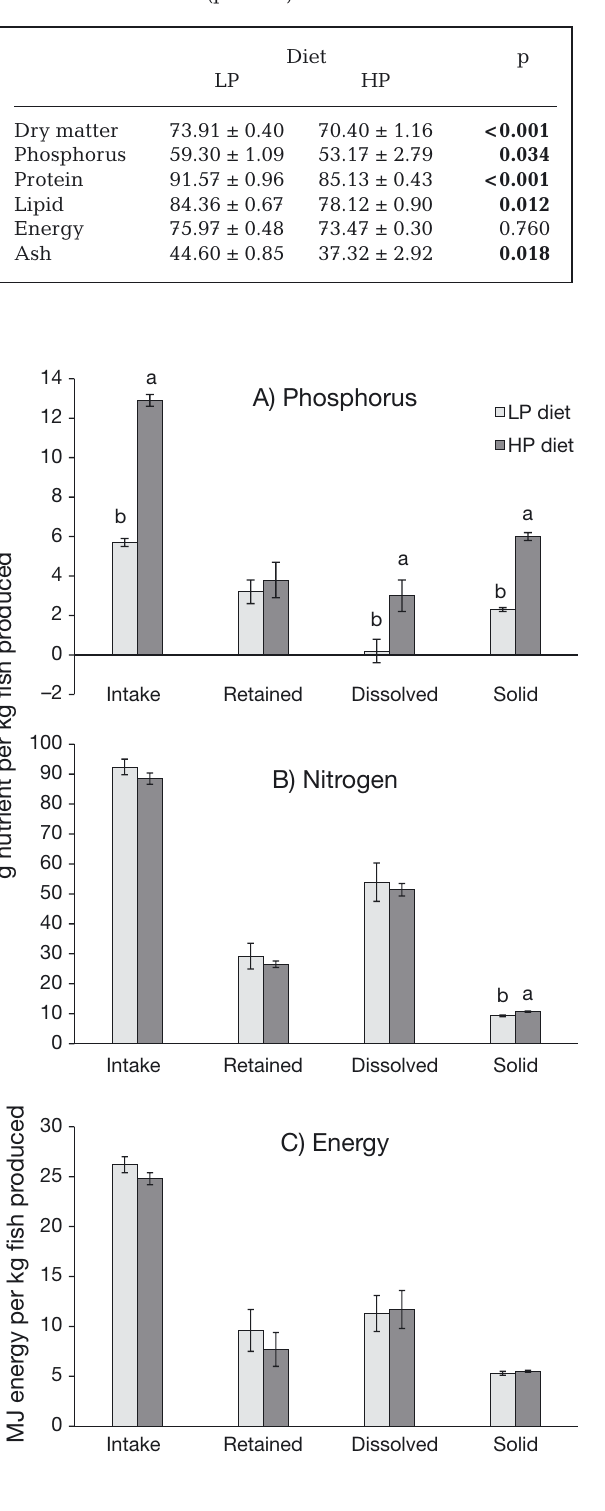
Table 4. Concentration (ppm) of inorganic anions in tank wa- Table 3. Apparent digestibility coefficient (ADC) (see Eq. 8 in ter at each sampling event for rainbow trout Oncorhynchus ‘Materials and methods’) for dry matter, phosphorus, protein, mykiss fed low-phosphorus (LP) and high-phosphorus (HP) lipid, energy and ash of rainbow trout Oncorhynchus mykiss diet. Values are mean ± SD (n = 4 tanks per diet). Significant fed low-phosphorus (LP) and high-phosphorus (HP) diet. Val- values (p < 0.05) in bold ues are mean ± SD (n = 4 tanks per diet). Significant values (p < 0.05) in bold